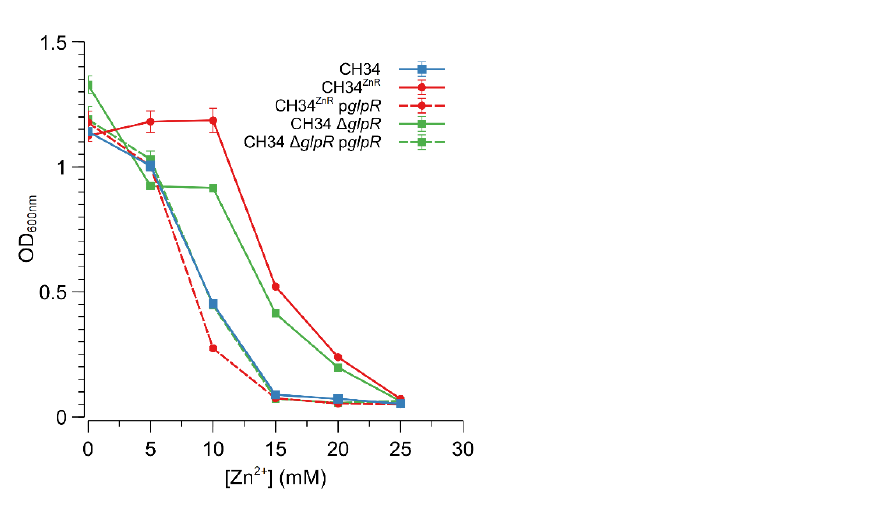
Figure 3. Zinc and cadmium resistance of C. metallidurans CH34 and its indicated derivatives. Zinc 323 (left) and cadmium (right) dose – response experiments with CH34 (blue full line, squares), 324 CH34 ZnR (red full line, circles) and their Δ 29-34 derivatives (blue dashed line with squares and red 325 dashed line with circles, respectively). The average values of three independent experiments with 326 standard deviations are shown.